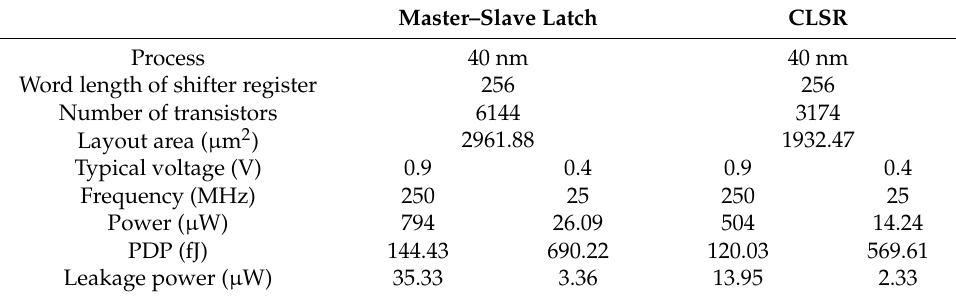
Table 2. Performance comparison of shift registers at TSMC 40